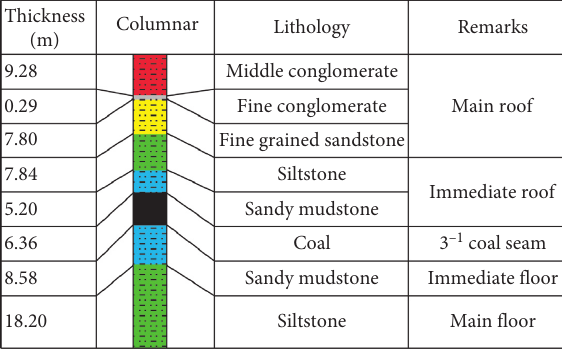
Figure 2: Column map of the